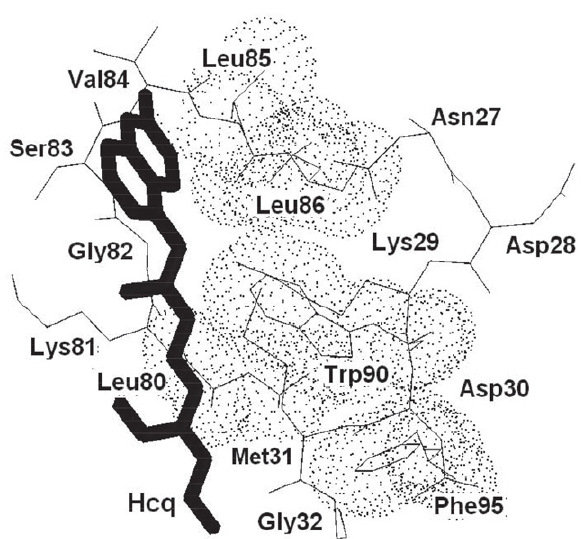
Figure 6. Hcq (bold sticks) that is docked in the binding site of the Thr31Met mutant of hCoV-OC43 S. The P1 (Leu85, Leu86 and Trp90) hydrophobic pocket (dots) accommodates the aromatic core scaffold of Hcq. No electrostatic contacts are